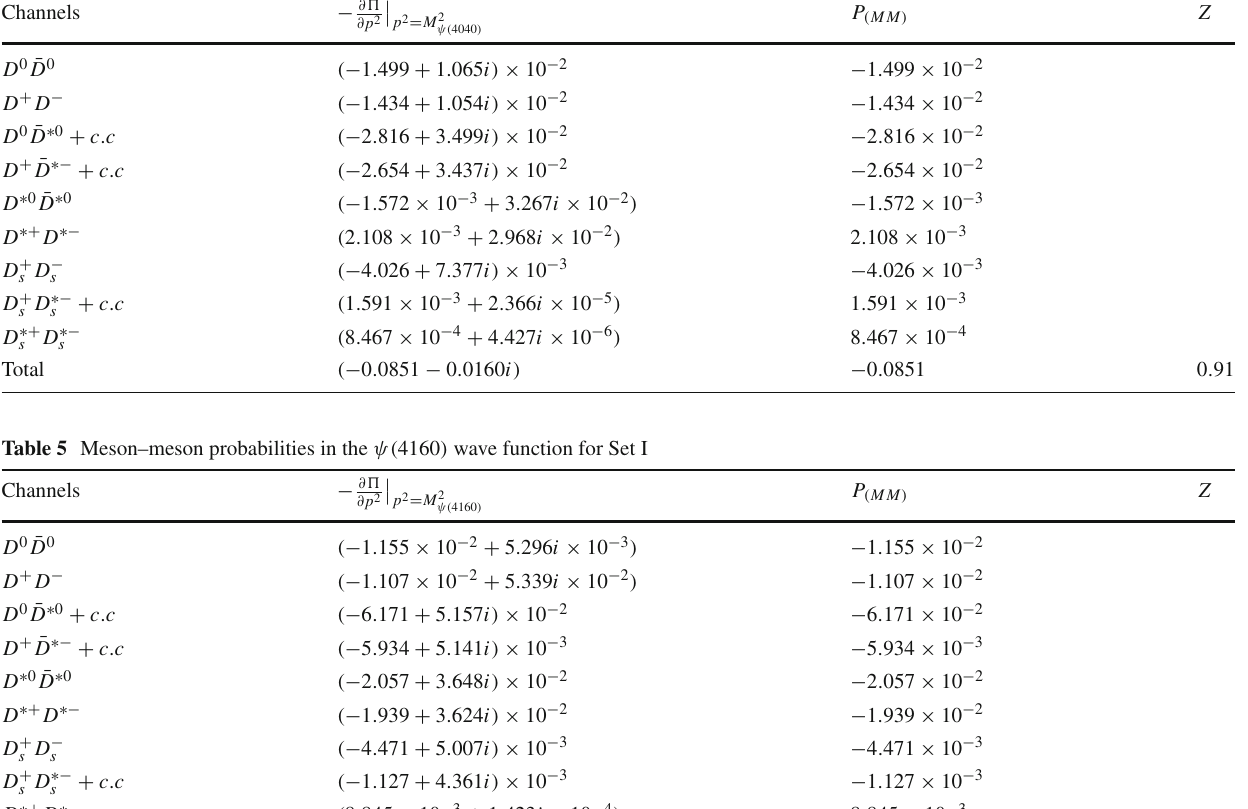
Table 4 Meson–meson probabilities in the ψ( 4040 ) wave function for Set I Channels